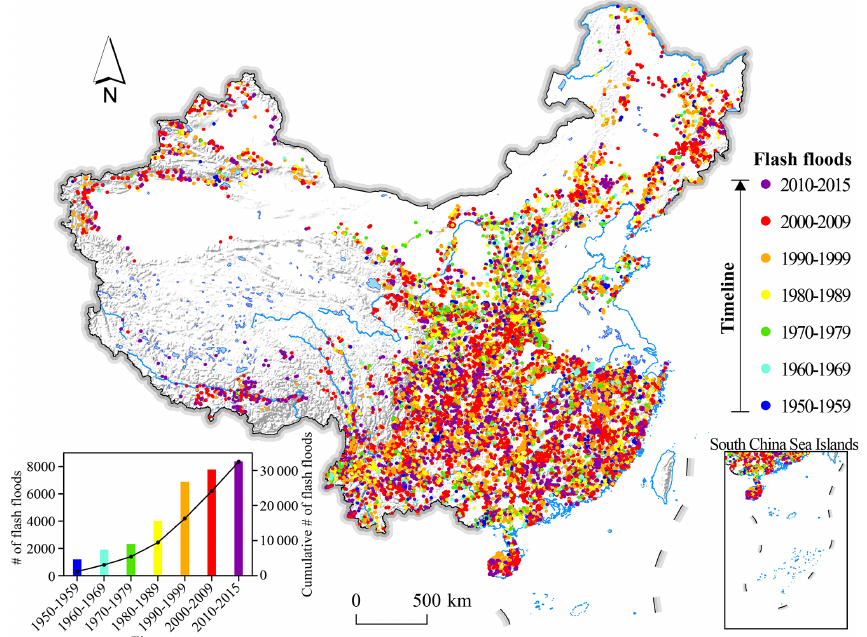
Figure 1. Spatiotemporal distribution of flash flood disasters in